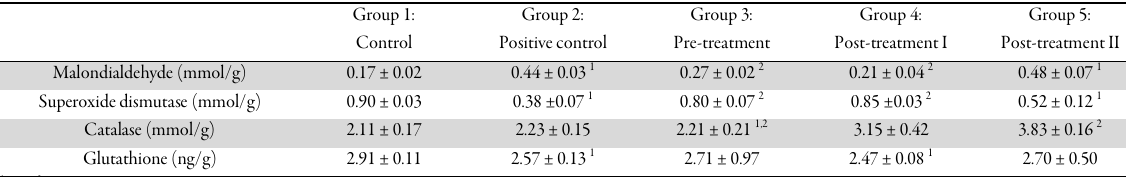
Table 1. Effect of aqueous leaf extract of Moringa oleifera on oxidative stress markers